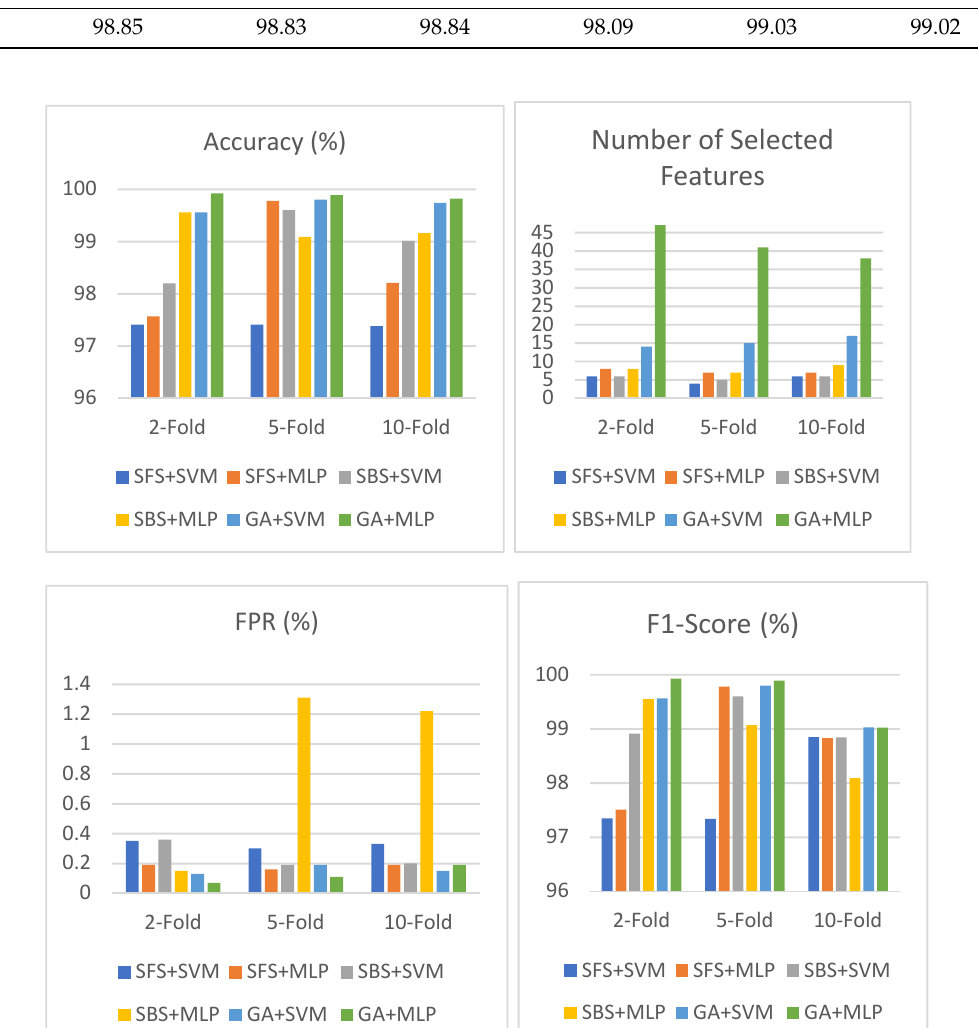
Figure 11. Performance of SFS, SBS, and GA using objective function based on DR, FPR, and number of selected features in CIC-IDS-2018.